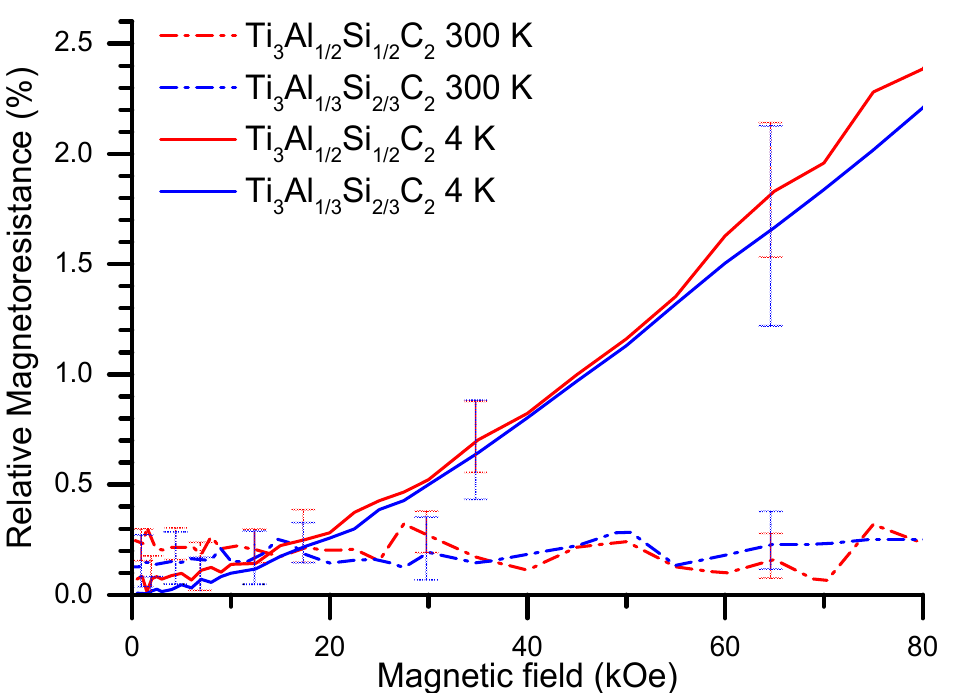
Figure 10. Magnetoresistance vs magnetic field strength of the MAX phase materials at 300 K and 4 K.